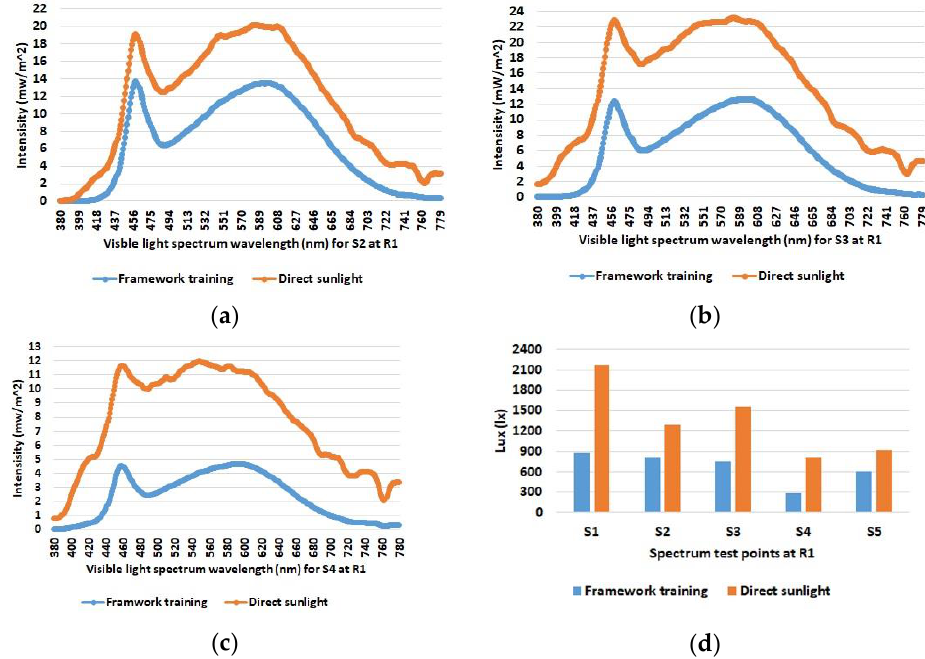
Figure 10. Spectral light distribution for the spectrum test points S2 ( a ); S3 ( b ); and S4 ( c ) — representing a diagonal line from the wall towards the windows in room 1 in comparison with (orange lines) and without (blue lines) direct sunlight. The illumination intensity at the five points in room 1 is compared in the given bar chart ( d ).